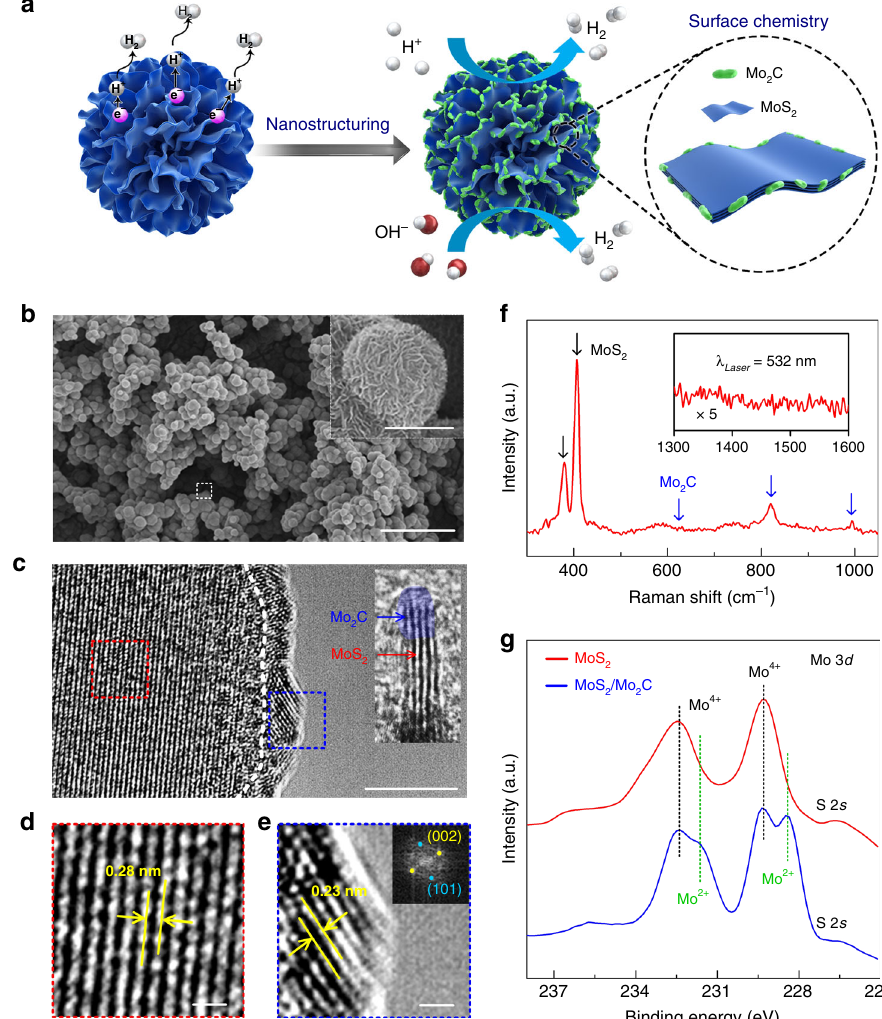
Fig. 1 Synthesis and characterization. a Design schematic of the MoS 2 /Mo 2 C. b Scanning electron microscopy (SEM) image of the synthesized MoS 2 / Mo 2 C. The scale bar is 20 μ m. The inset is an enlarged view of the dotted square and is a microsphere of MoS 2 /Mo 2 C. The scale bar is 1 μ m. c – e High- resolution transmission electron microscopy (HRTEM) images of the MoS 2 /Mo 2 C. Insets in ( c ) and ( e ) are enlarged views and the corresponding fast Fourier transform (FFT) pattern, respectively. The images ( d ) and ( e ) are enlarged views of the squares outlined in red and blue in ( c ). The scale bars are 5 nm in ( c ) and 0.5 nm in ( d , e ). f Raman spectrum of MoS 2 /Mo 2 C. Inset shows a spectrum from 1300 to 1600 cm − 1 , indicating no graphitic carbon materials were produced. g X-ray photoelectron spectroscopy (XPS) spectra of Mo 3 d of MoS 2 and MoS 2 /Mo 2 C. Two peaks originating from Mo 2 + appear in the MoS 2 /Mo 2 C